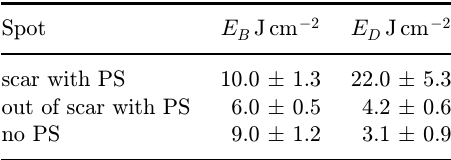
Table 1. Characteristic expositions for PpIX bleaching ( E B ) and dominance of the 675 nm spectral band ( E D